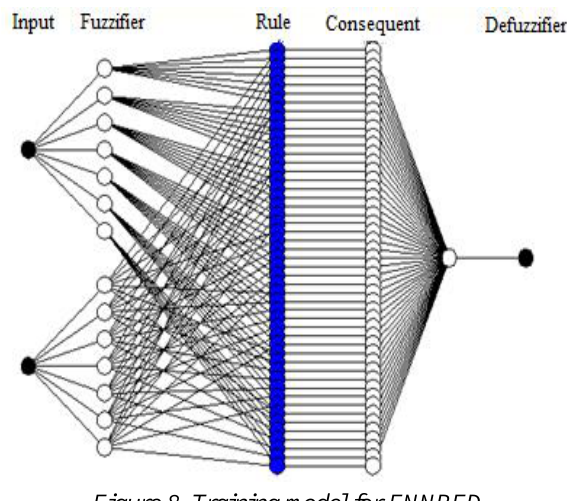
Figure 8. Training model for FNNRED